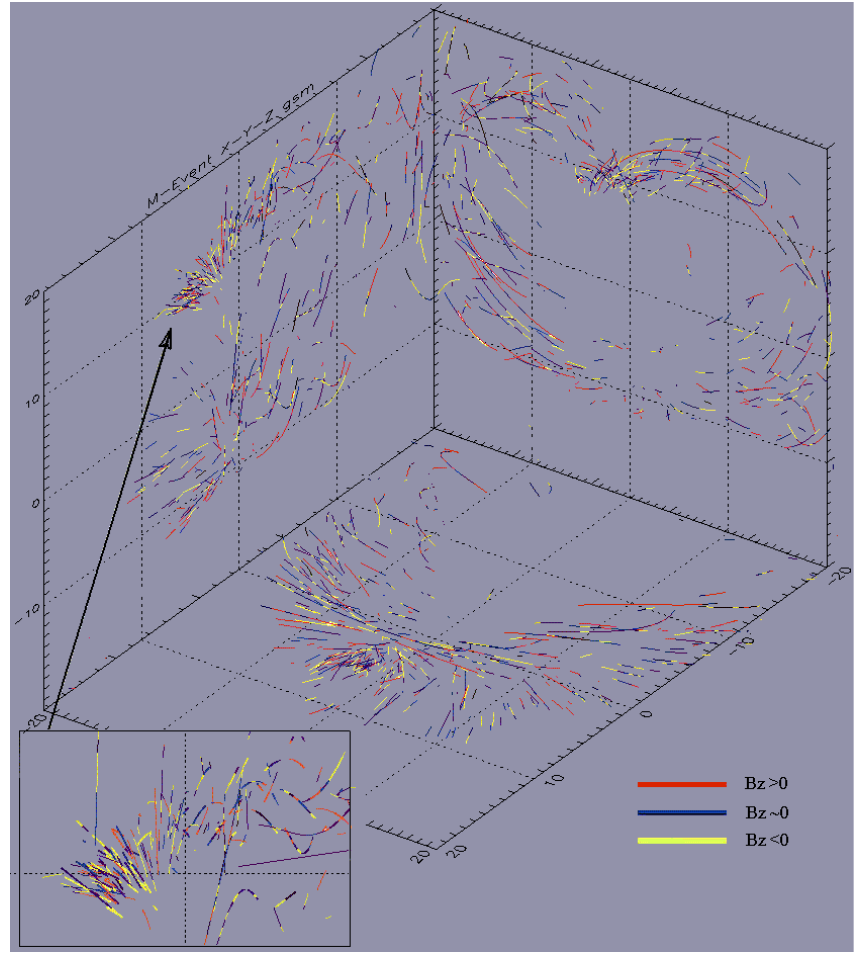
Fig. 8b. TBL in 1995–1998 from Interball-1 magnetic field data in 3 GSM planes for the full standard devi- ation > 6nT. The IMF B z -dependence is color-coded according to the scale at the bottom of the figure and shown at the pieces of orbit traces of Interball- 1 (see the TBL definition in the text); red color – B z > 2nT, yellow color – B z < − 2nT, blue color – B z between 2 and − 2nT. The insert in the left bot- tom corner shows higher resolution of the near-cusp TBL from the plane ( XZ ) as shown by the arrow. Note the lack of Interball-1 orbit coverage of the MP, marked by violet dot-shading in Fig.